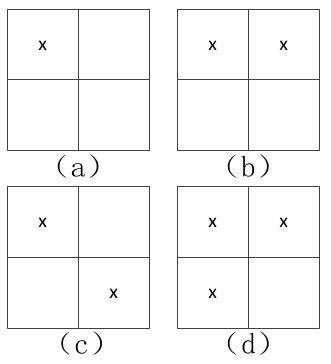
Figure 3. The four modes of edge pixels based on sub-pixel.